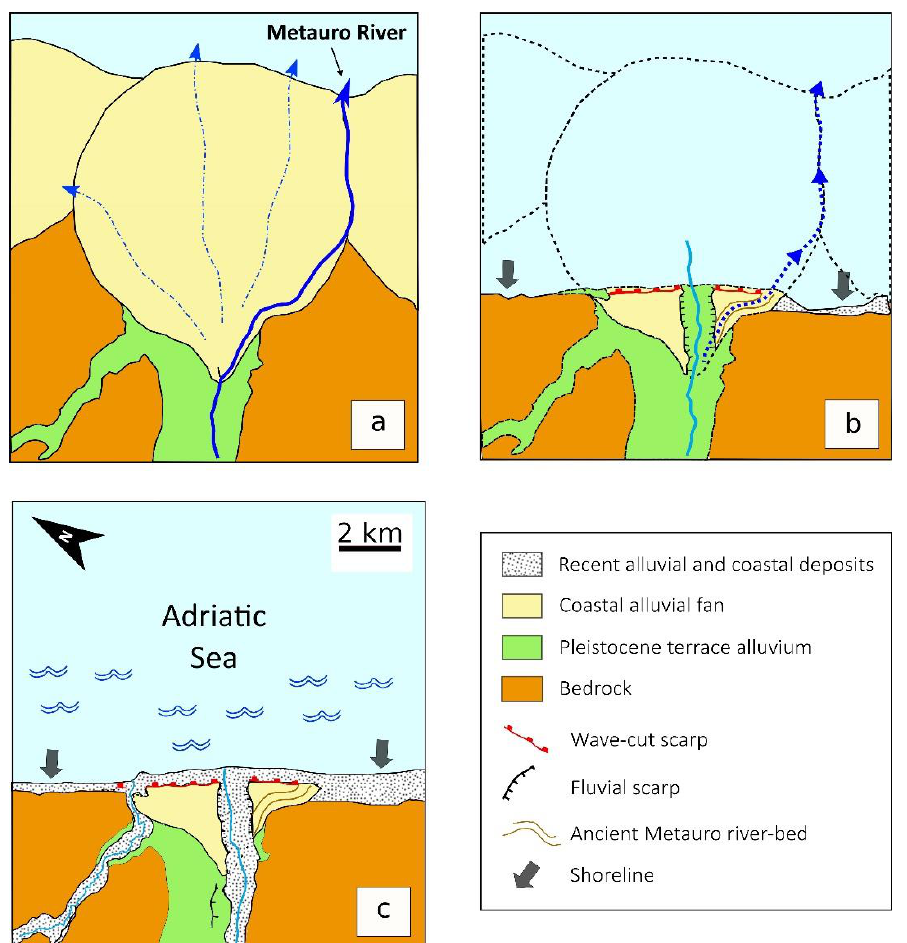
Figure 2. Model of interaction of the river and sea on the morpho-evolution of the coast in the Northern Marche sector. The example of the Metauro river mouth: ( a ) Maximum expansion of the coastal fan during a low-stand; relationships with adjacent fans of the Foglia (to the north) and Cesano (to the south) rivers; ( b ) maximum retreat of the coast line with erosion and development of a coastal scarp; ( c ) present-day situation (after [37], Figure 3, simplified).